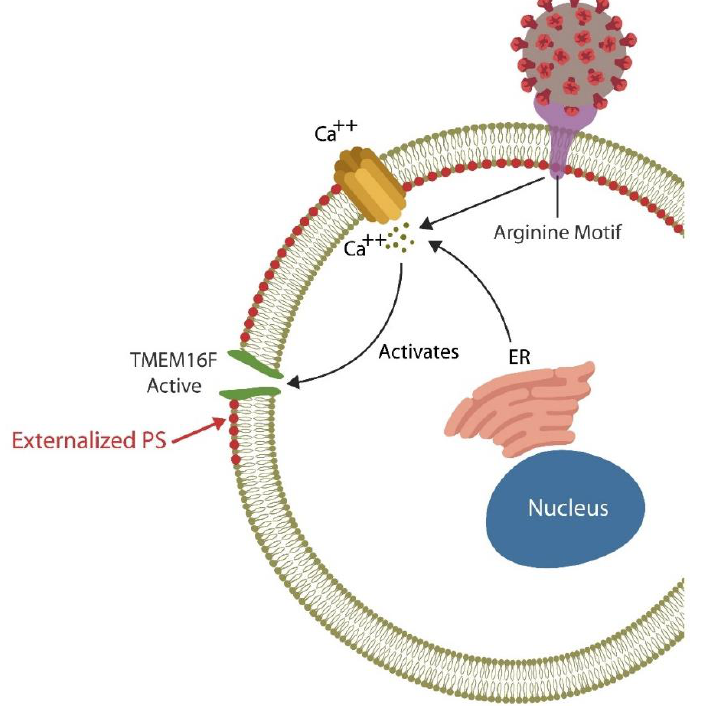
Figure 1. The SARS-CoV-2 receptor binding site (RBS) contains a double arginine insert (PRRA) or arginine motif, that perforates the cell membrane, triggering Ca2+ influx from both the endoplasmic reticulum (ER) and the extracellular compartment. Upregulated cytosolic Ca2+ activates TMEN16F, externalizing phosphatidylserine (ePS), an “eat me” or “fuse me” signal that leads to cell death (if the damage is irreparable) or cell–cell fusion (if the cell can be repaired). Cell–cell fusion or syncytia formation induces premature cellular senescence, disrupting biological barriers. The virus benefits from ePS as this comprises a global immunosuppressive signal, allowing its undetected entry into host